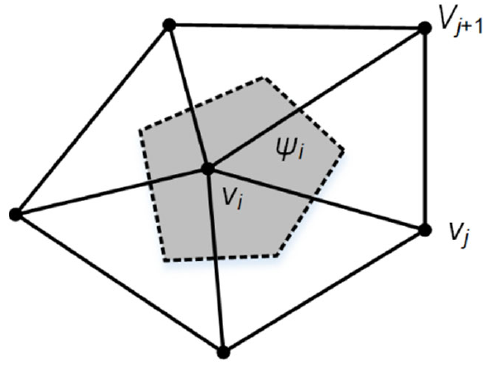
where S is the spherical area of ∆ v i v j v j +1 .